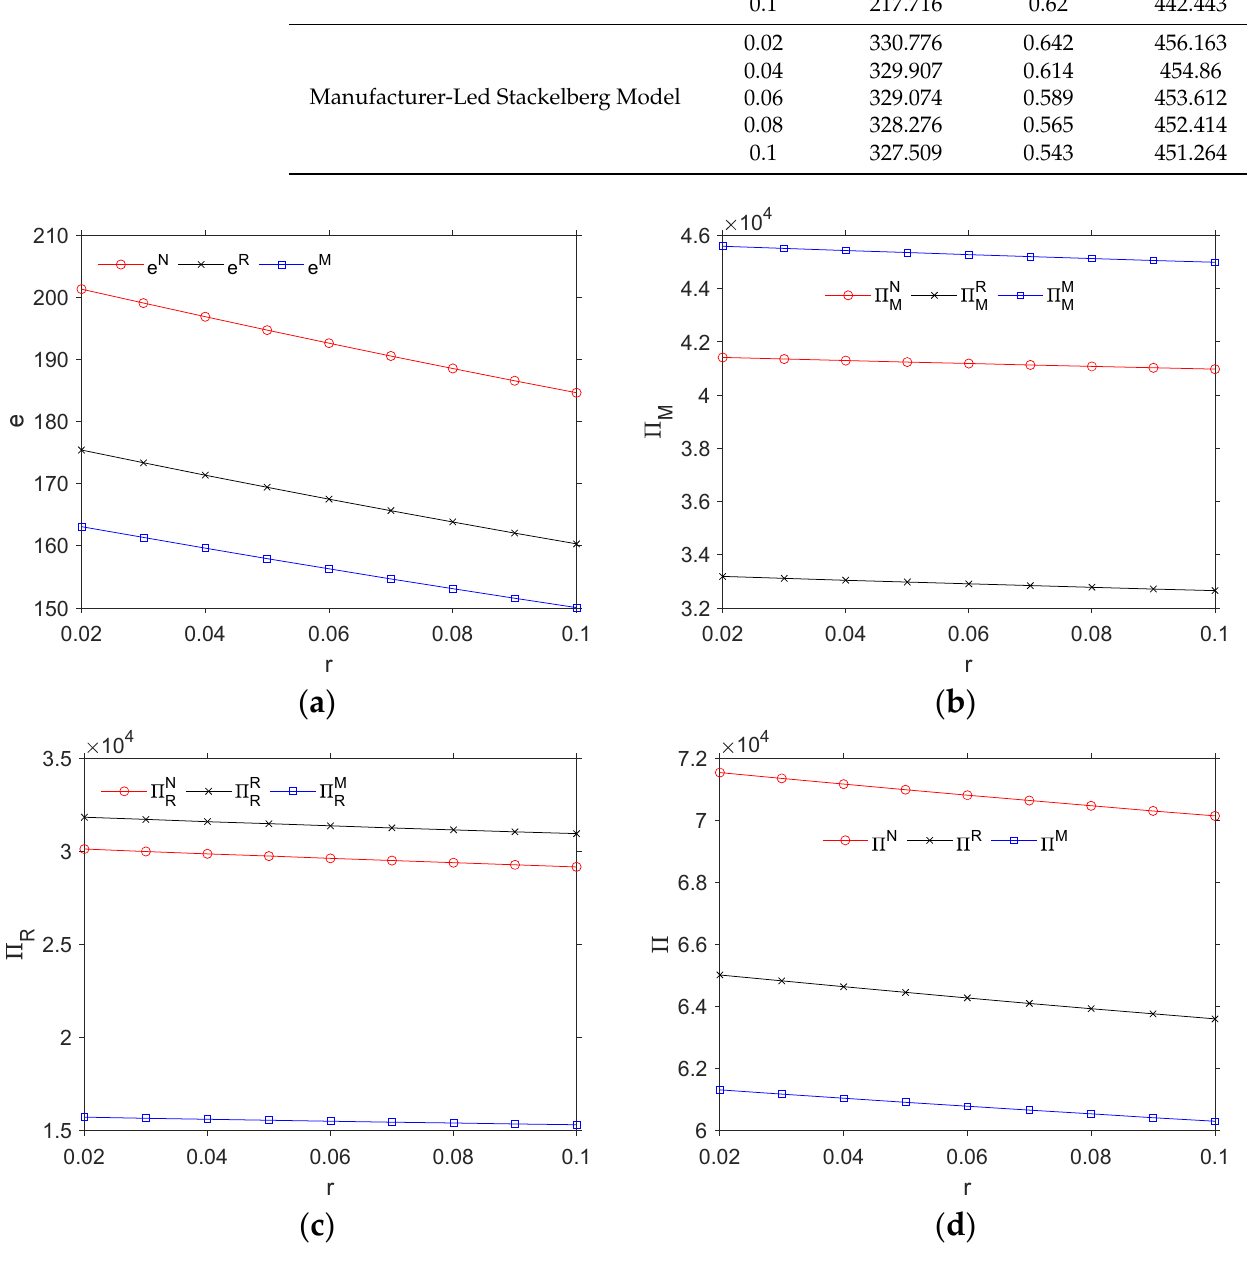
Figure 4. The changes in the supply chain profits ( b – d ) and carbon emissions reduction levels ( a ) that were caused by r .